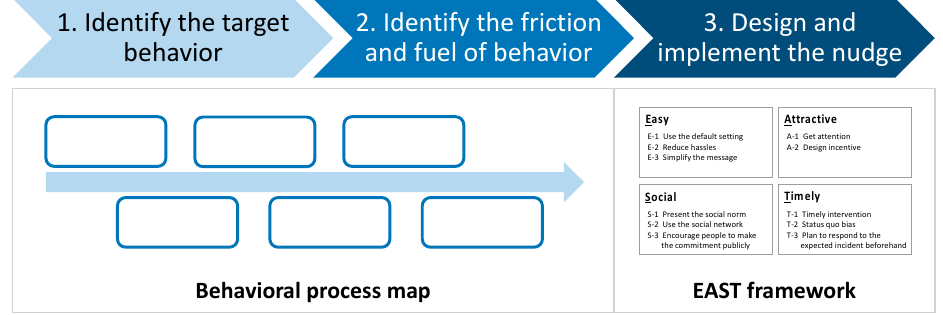
Figure 3. Three steps to design a nudge practice.